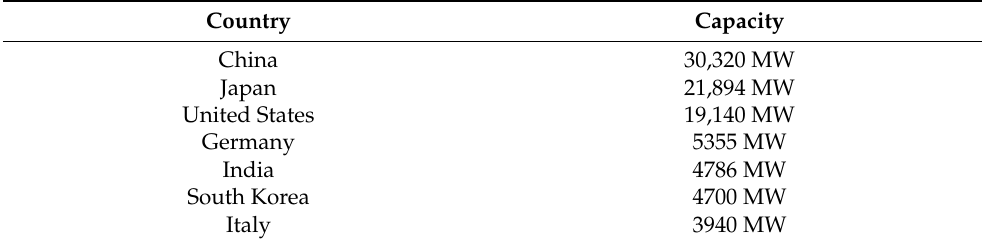
Table 2. Top global pumped hydro energy